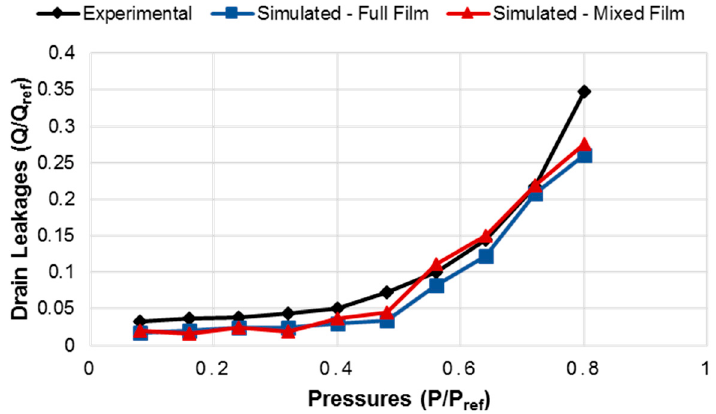
Figure 17. Comparison of measured drain leakages with the simulated ones from the full and mixed film models at an operating speed of 2000 rpm.